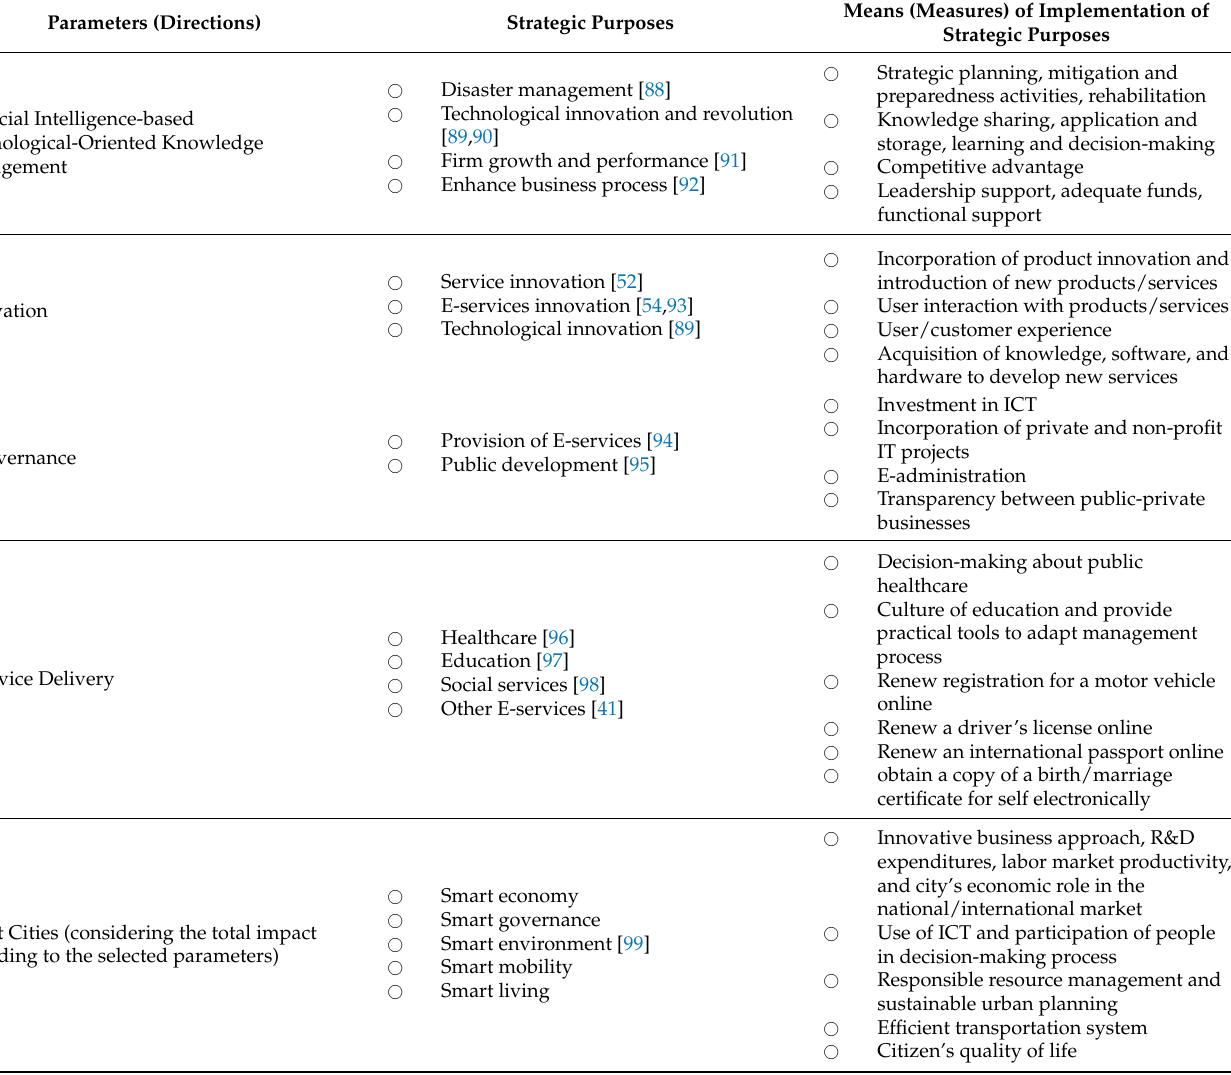
Table 7. Directions and means of development of technology-oriented knowledge management based on artificial intelligence, innovations, and the provision of electronic services in smart cities. Strategic